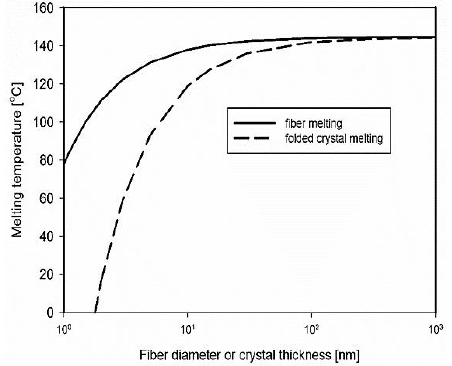
Figure 4. Depression of melting temperature due to the contribution of interfacial free energies of lateral surfaces of dis-UHMWPE crystals in the nanofibers embedded in EOC and due to surfaces consisting of chain folds. (Thermal data for polyethylene: σ sl = 11.8 mN/m, σ e = 90 mN m − 1 , T m 0 = 144.5 °C, and Δ h f 0 = 293 J cm − 3 taken from [46,47,53]).